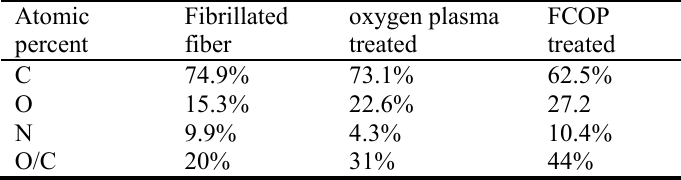
Table 2. The surface elemental composition results by XPS.